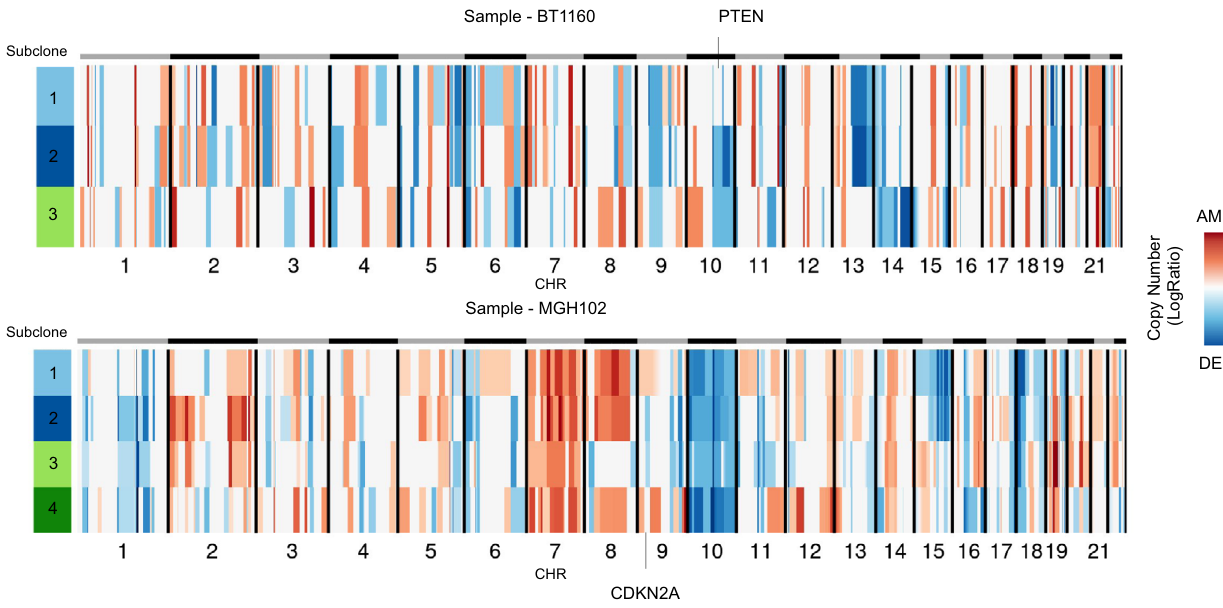
Fig. 5 | Tumor suppressor genes in the clonal substructure. Compact repre- sentation of clonal structure inferred with SCEVAN of scRNA-seq samples BT1160